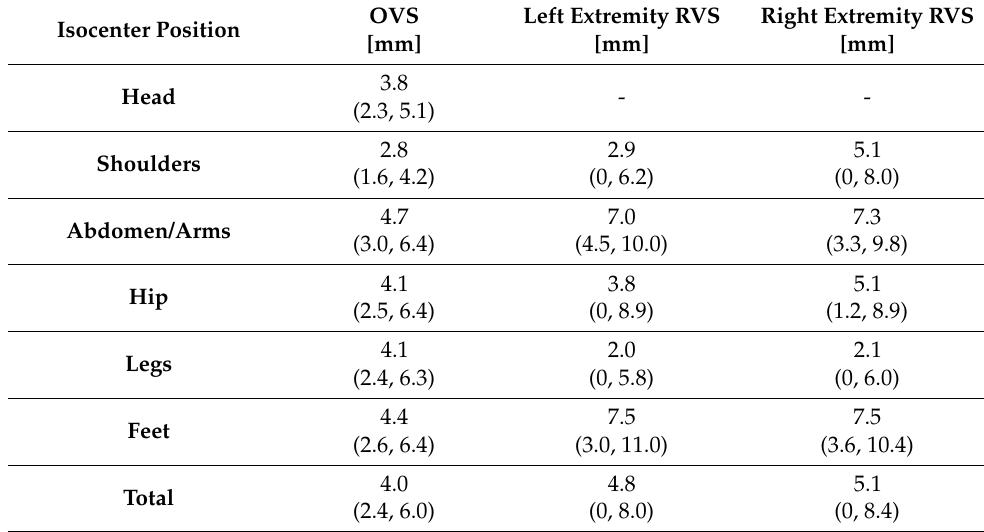
Table 1. Median values of the OVS between CBCT-CT and the RVS for the extremities, for each isocenter position. IQR values are reported in